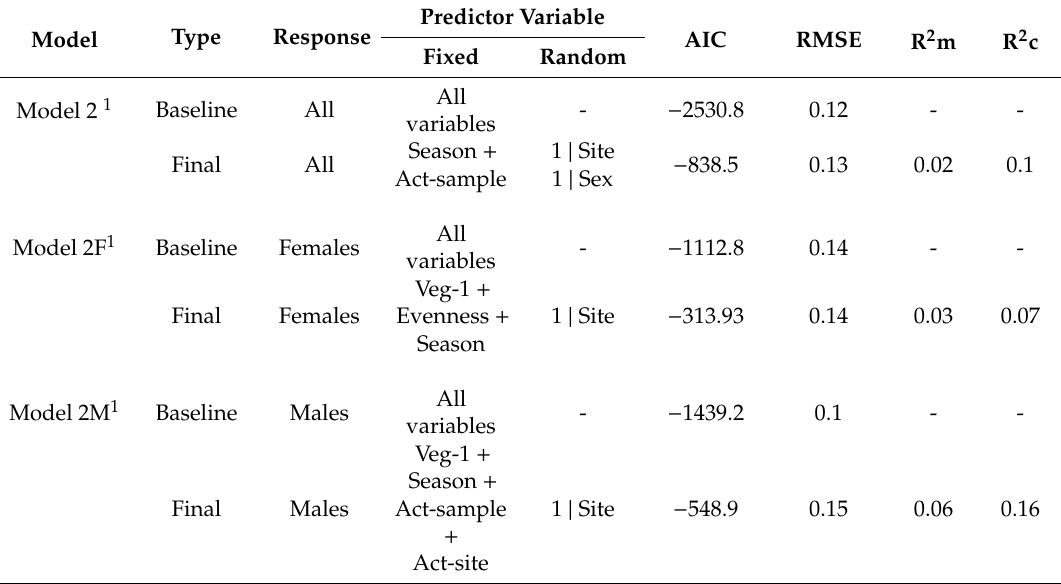
Table 3. Model selection to explain the patterns of body size in the wolf spider Pardosa palustris . Final models were selected by stepwise deletion of fixed e ff ects based on Akaike’s information criterion (AIC). Collinear variables were not included in this study. RMSE = root mean squared error, R 2 m = marginal R 2 , R 2 c = conditional R 2 ; see Table 1 for a detailed explanation of the variables.